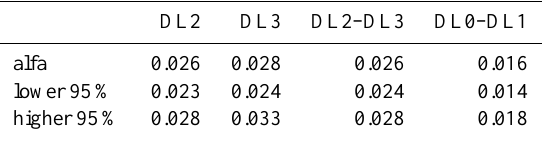
Table 3. Regression coefficient for different grouping of height/period data according to observed EMS 98